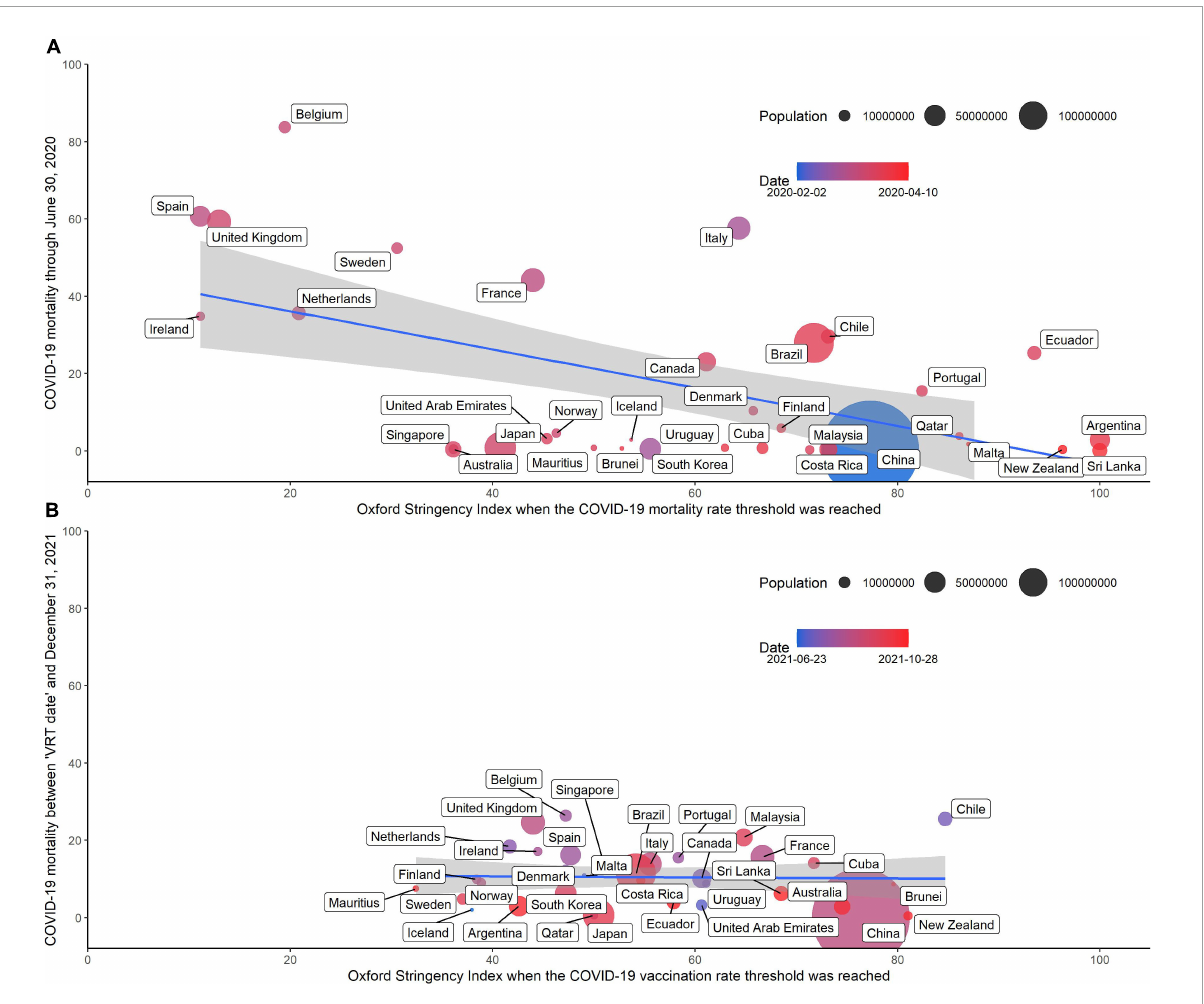
FIGURE1 (A) The OSI on the day of reaching the COVID-19 mortality rate threshold and cumulative COVID-19 mortality through June 30, 2020. (B) The OSI on the day of reaching the COVID-19 vaccination rate threshold and cumulative COVID-19 mortality between the day of reaching the COVID-19 vaccination rate threshold and December 31,